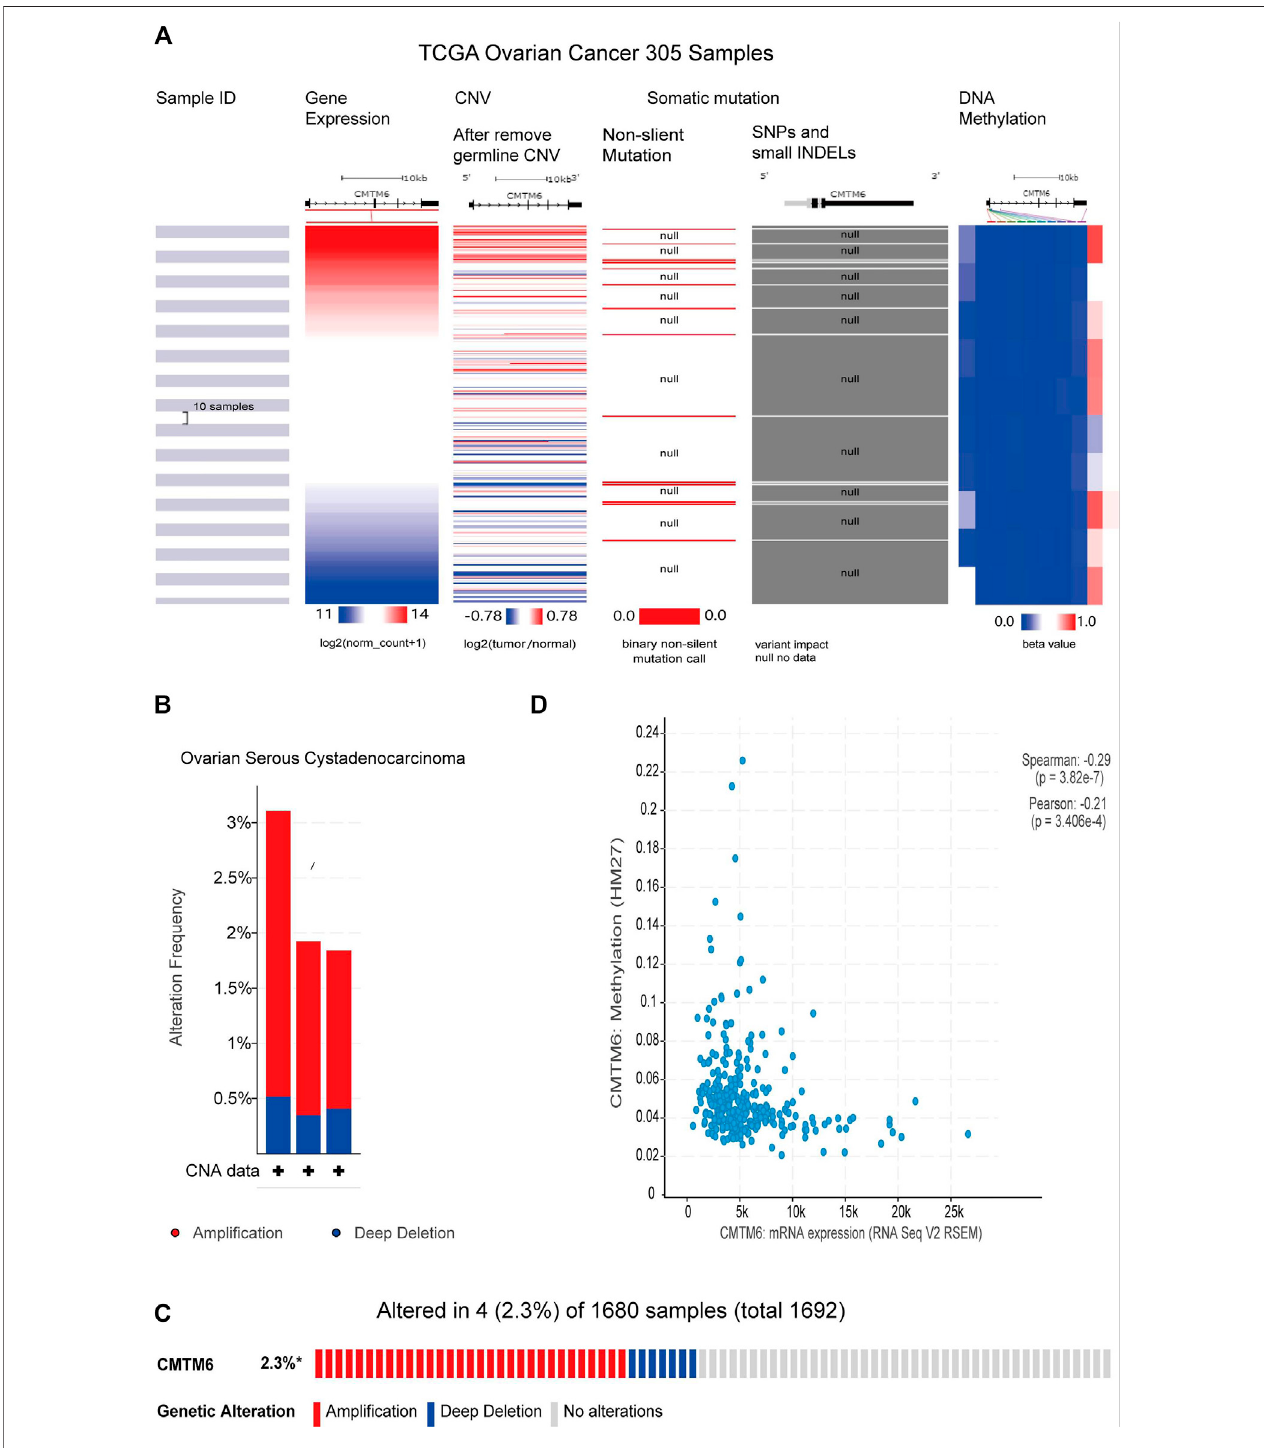
FIGURE 9 | CNV, methylation, and mutation analysis of CMTM6 in OV (UCSC Xena and cBioPortal). (A) Heatmap viewing the associations between CMTM6 mRNA and CNV, methylation, and somatic mutations in OV. (B,C) Summary of genetic alteration feature of CMTM6 within OV. CMTM6 was altered in four samples of 1,680 samples with OV (2.3%). (D) Relation of CMTM6 expression and the methylation level for OV.